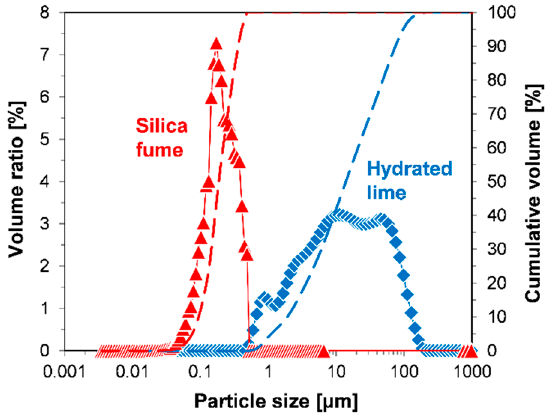
Figure 1. Particle size distribution of hydrated lime and silica fume.